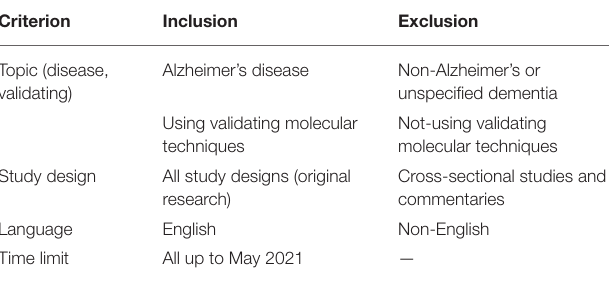
TABLE 1 | Inclusion and exclusion criteria.